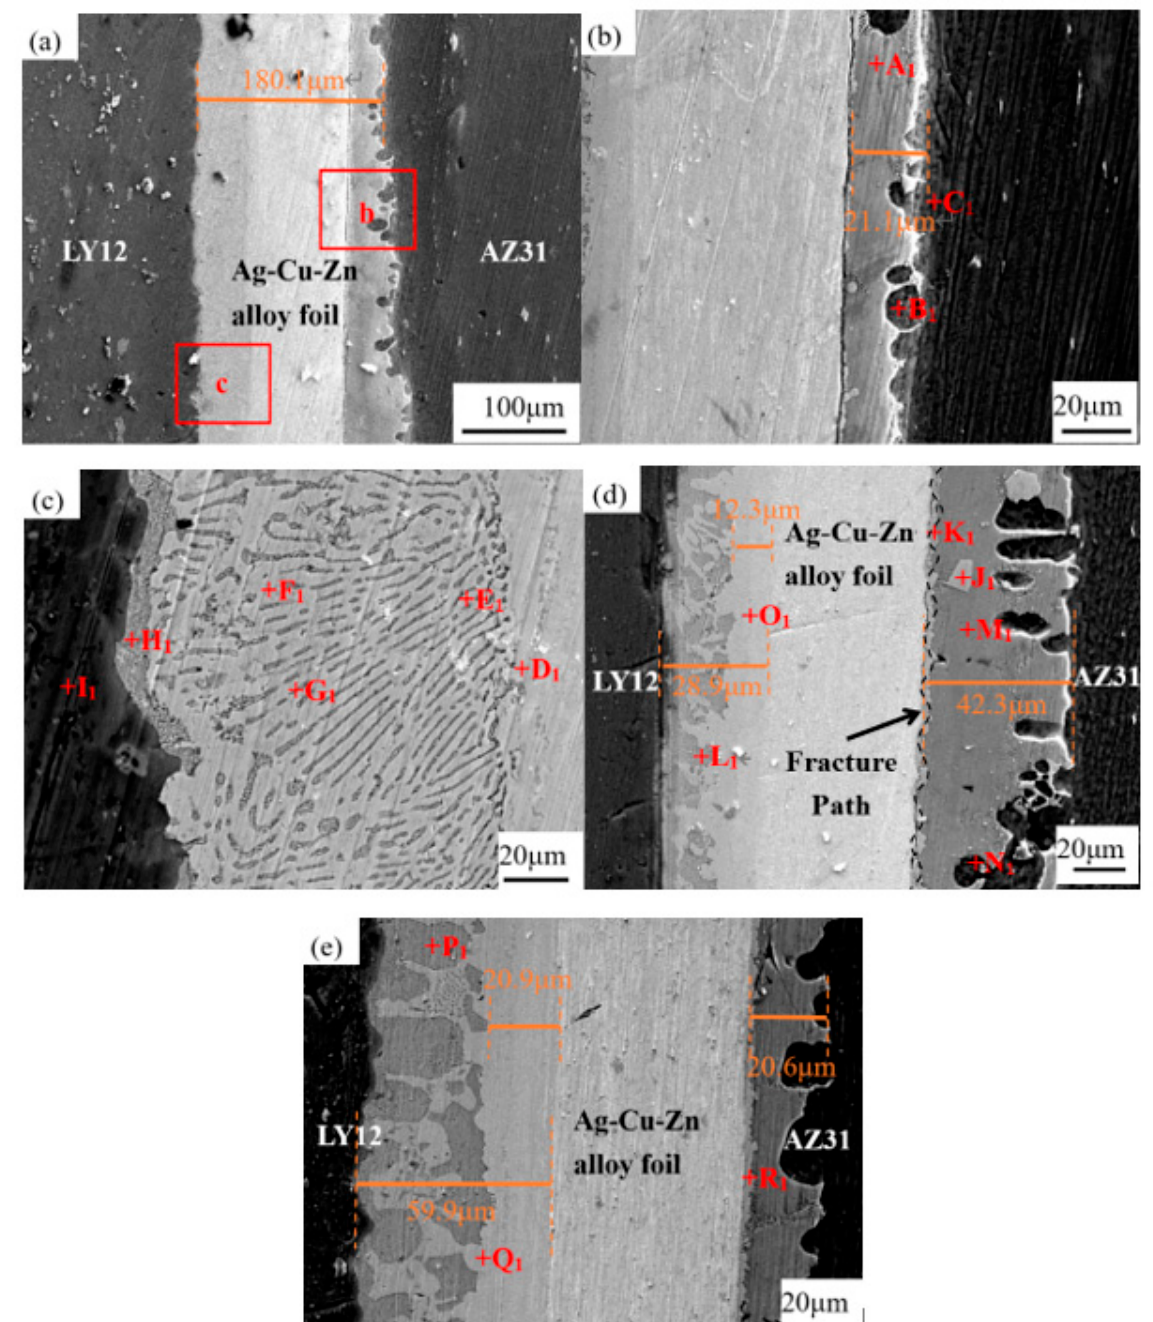
Figure 2. Microstructure evolution of the joints with increasing UST at 410 ◦ C: ( a – c ) 5 s; ( d ) 10 s; and ( e ) 15 s. Panel ( b ) refers to area b in ( a ) and panel ( c ) refers to area c in ( a ). The reaction on both sides of the joints was even when the UST was 5 s, as shown in Figure 2a. The Ag–Cu–Zn alloy foil acts as a “physical barrier” to block the contact between AZ31B and LY12 BMs, and obvious defects can be observed on the AZ31B side of the joint. Panel (b) is area b in (a). As observed in panel (b), the Zn foil had been consumed completely after 5 s UST. The gray layer of Mg 7 Zn 3 was generated because of the Zn–Mg eutectic reaction (region A 1 ), and a small amount of α -Mg (region B 1 ) grew into the AZ31B side of the joint. Cracks were obvious and could be seen between the Mg 7 Zn 3 IMC and the Ag–Cu–Zn interlayer. The observation shows that it is the Zn foil and not the